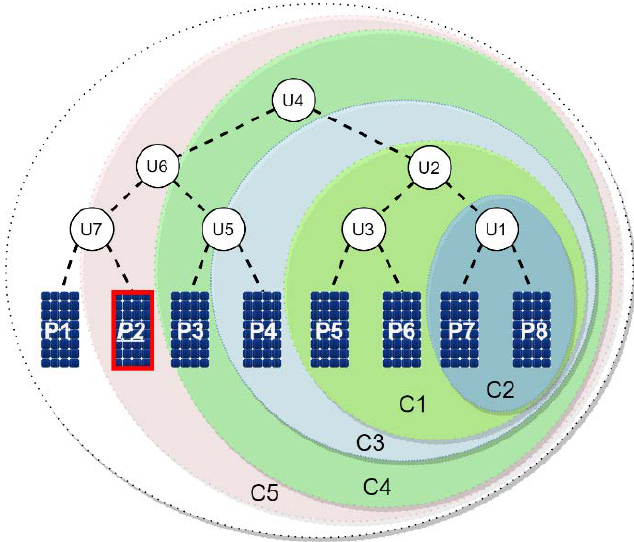
Figure 12. An example scenario for the tree search fault detection .